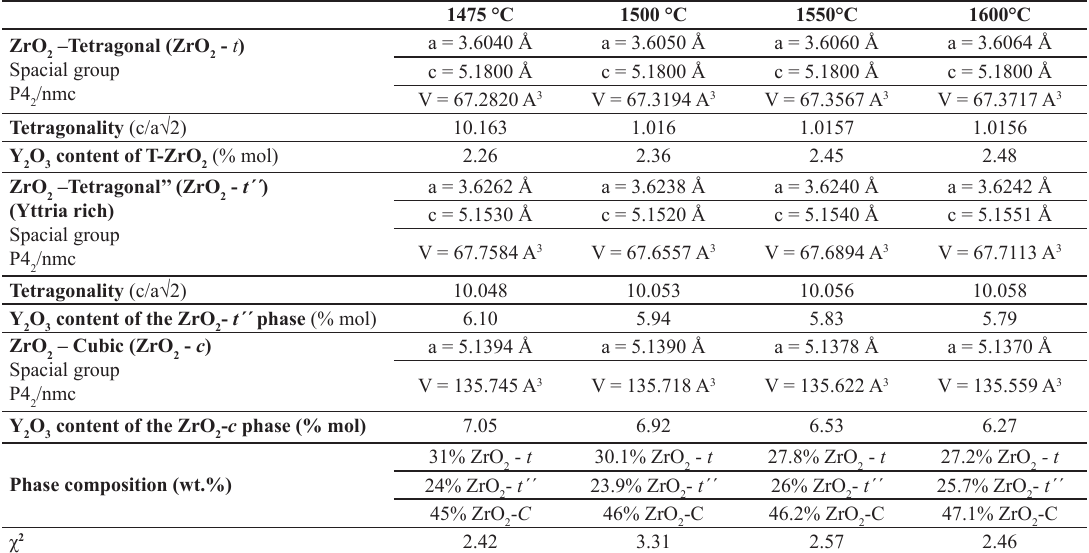
O + Fe O ) in regard to sintering temperature. 2 3 2 3